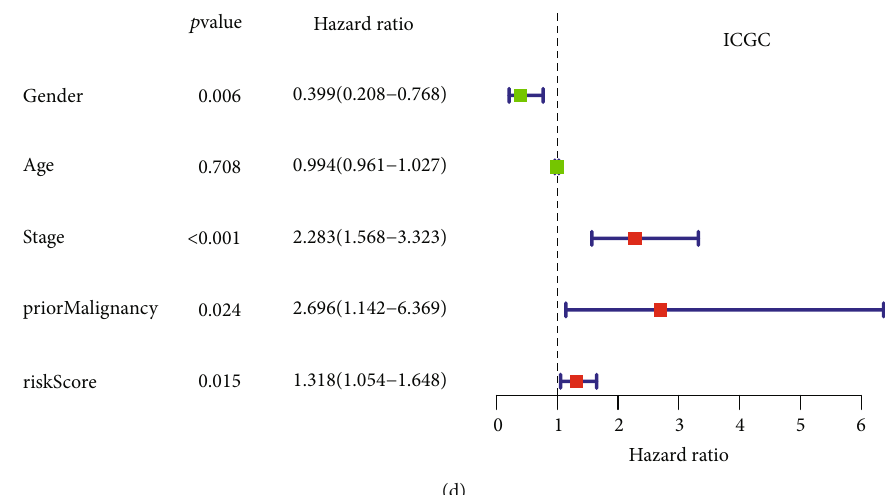
Figure 4: Cox regression analysis of the association between clinicopathological features and the overall survival of HCC patients. Univariate/multivariate Cox regression analyses of the association between clinicopathological factors (including the risk score) and overall survival of patients in the TCGA (a and b) and ICGC (c and d)